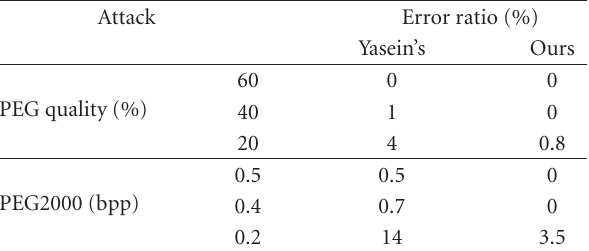
Table 3: Comparison to Yasein’s